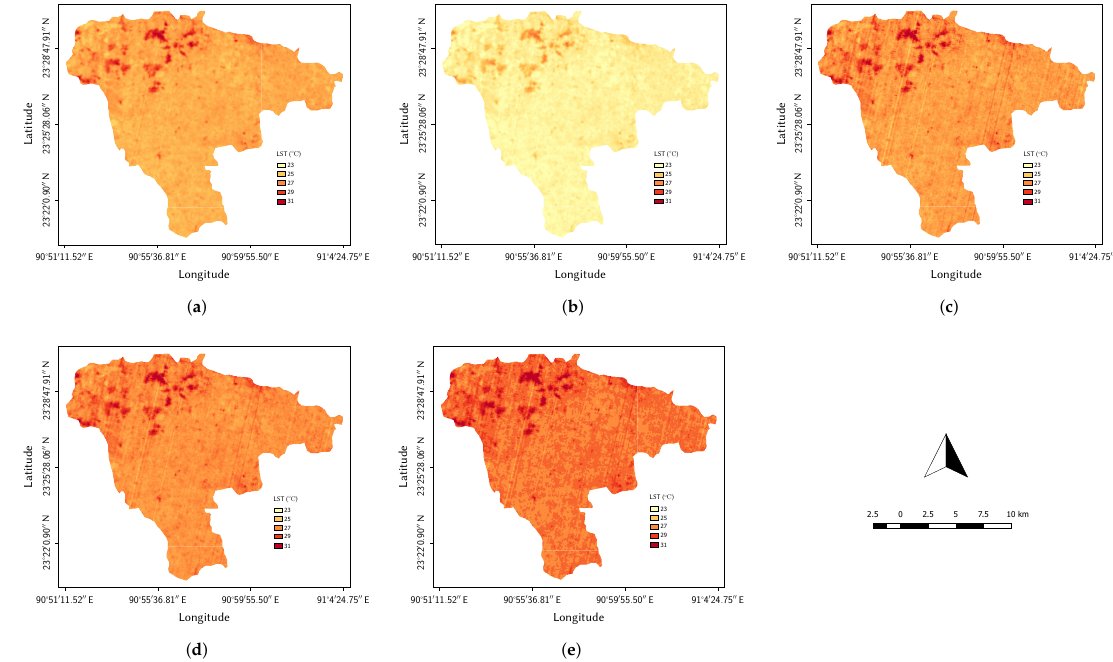
Figure 9. LST maps of the agricultural study area (Landsat 8 image of 21 February 2018): ( a ) RTE-based method using TIR band 10 ( τ = 0.76, L up = 1.94Wm − 2 sr − 1 µm − 1 , L down = 3.19Wm − 2 sr − 1 µm − 1 ), ( b ) Single-Channel algorithm using TIR band 10 ( w = 2.0gcm − 2 ), ( c ) Du et al.’s [40] Split-Window algorithm ( w = 0.0to 6.3gcm − 2 ), ( d ) Jiménez-Muñoz et al.’s [37] Split-Window algorithm ( w